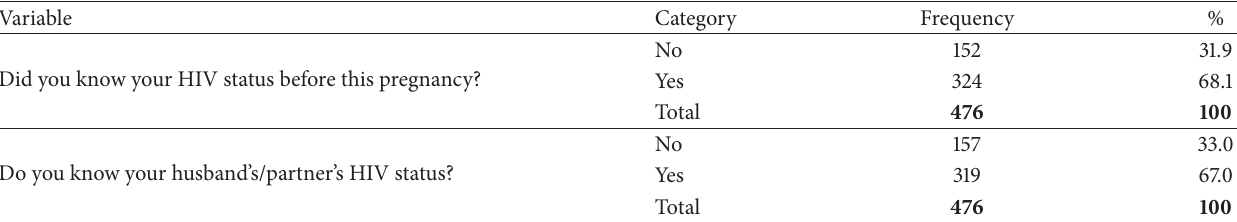
Table 4: Participants’ knowledge of their HIV statuses and those of their partners before first antenatal care (booking) visit.